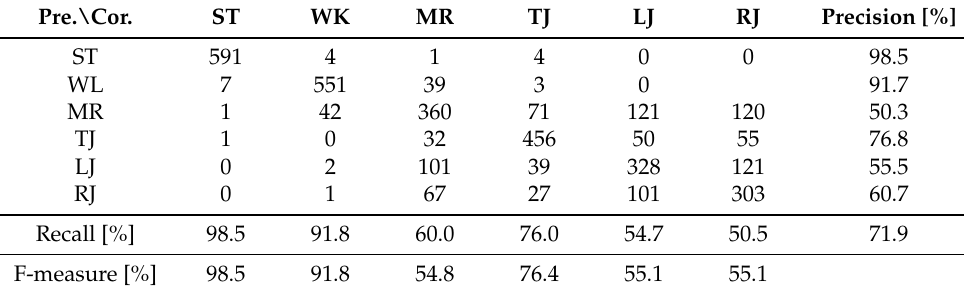
Table 5. Confusion Matrix of the RF.